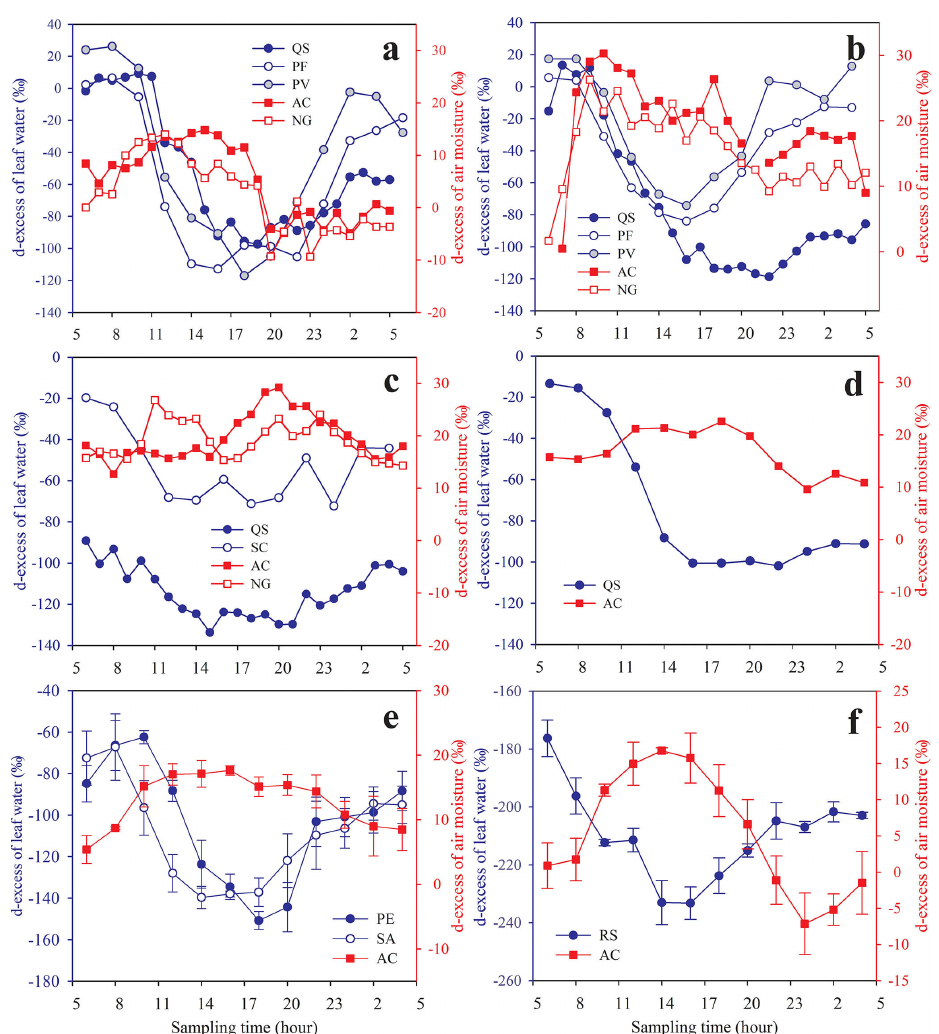
Figure 9. Comparison of leaf water and air moisture d-excess values during the sunny days. Note: panels (a) , (b) , (c) , (d) , (e) and (f) refer to the same locations as in Fig. 2, and the abbreviations of plant Latin names are the same as in Table 3. AC and NG refer to air moisture at the canopy level and near the ground,